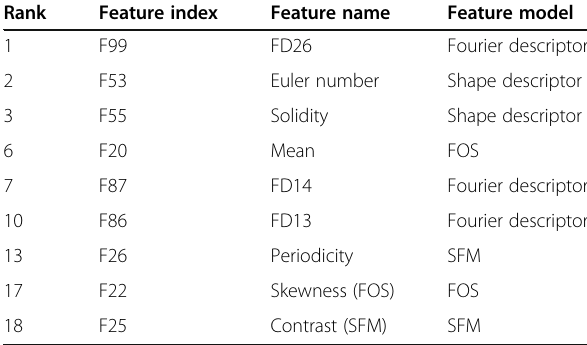
Table 13 Experimentally selected top nine most discriminative features out of 20 features selected by Relief-F method Rank